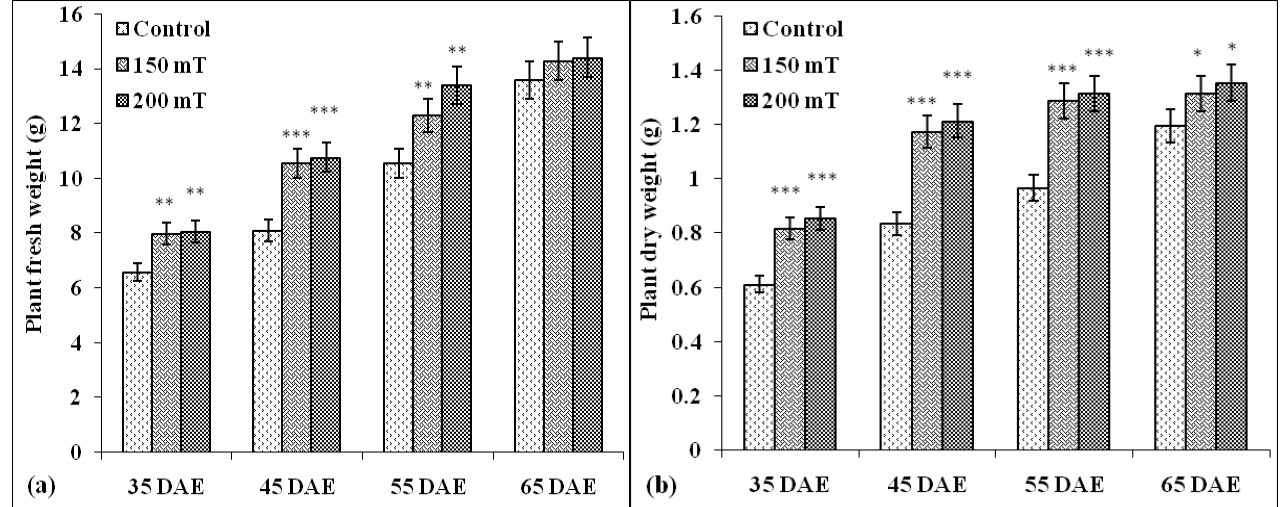
Figure 5. Effect of pre-sowing magnetic field treatment of soybean seeds on plant fresh weight ( a ) and plant dry weight ( b ). ***, ** and * indicate significance at p < 0.001, 0.01 and 0.05, respectively, compared to control.